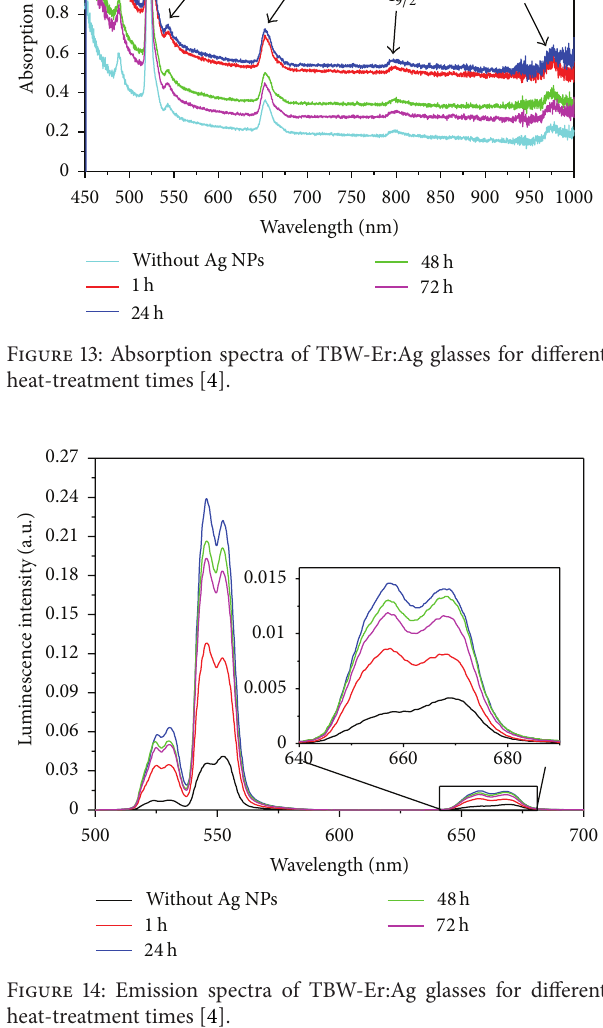
Figure 12: Simplified energy level diagram of Tm 3+ ions with indication of the upconversion pathways and wavelengths [3].